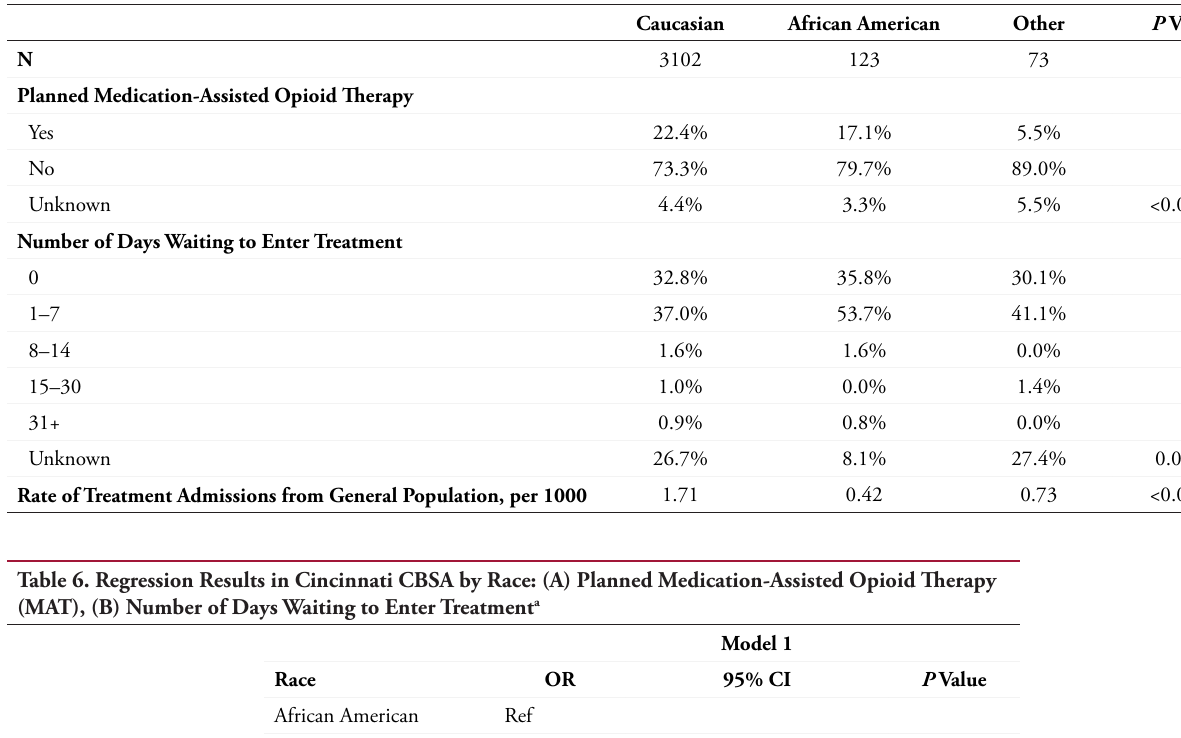
Table 5. Unadjusted Outcome Results by Race/Ethnicity in Cincinnati CBSA